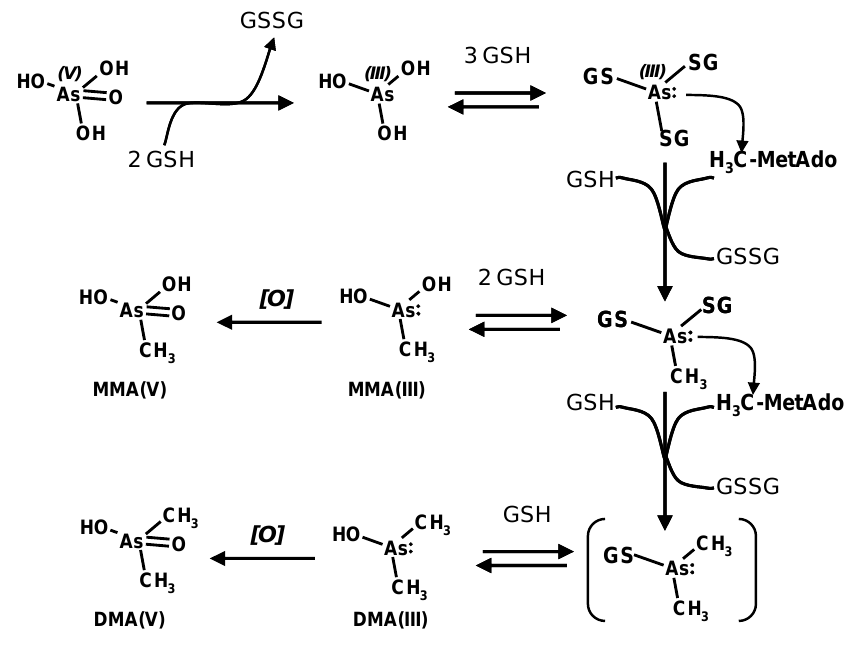
Scheme 5. Glutathione-mediated biotransformation of arsenate. Adapted and integrated from Reference [57]. Copyright 2005, The Pharmaceutical Society of